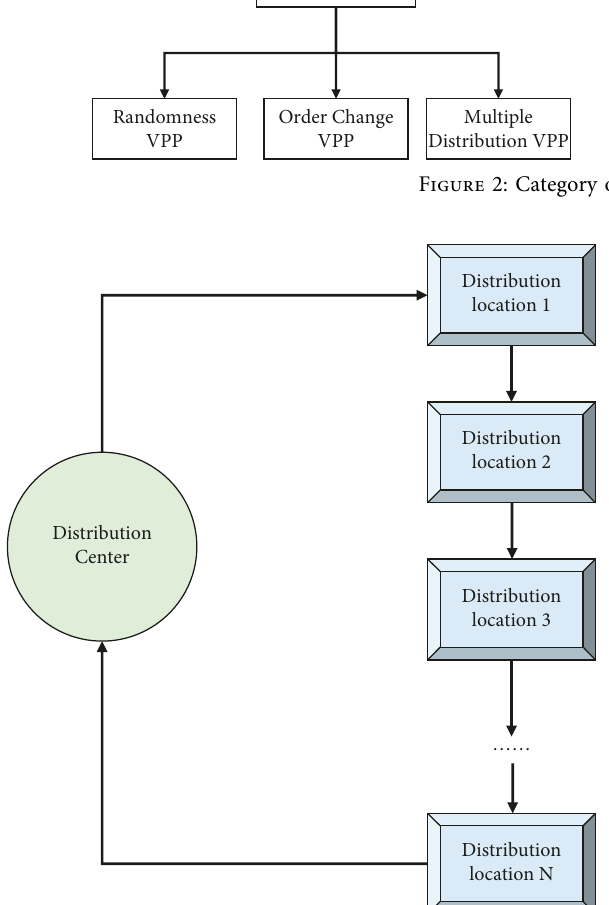
Figure 3: Transportation process of logistic